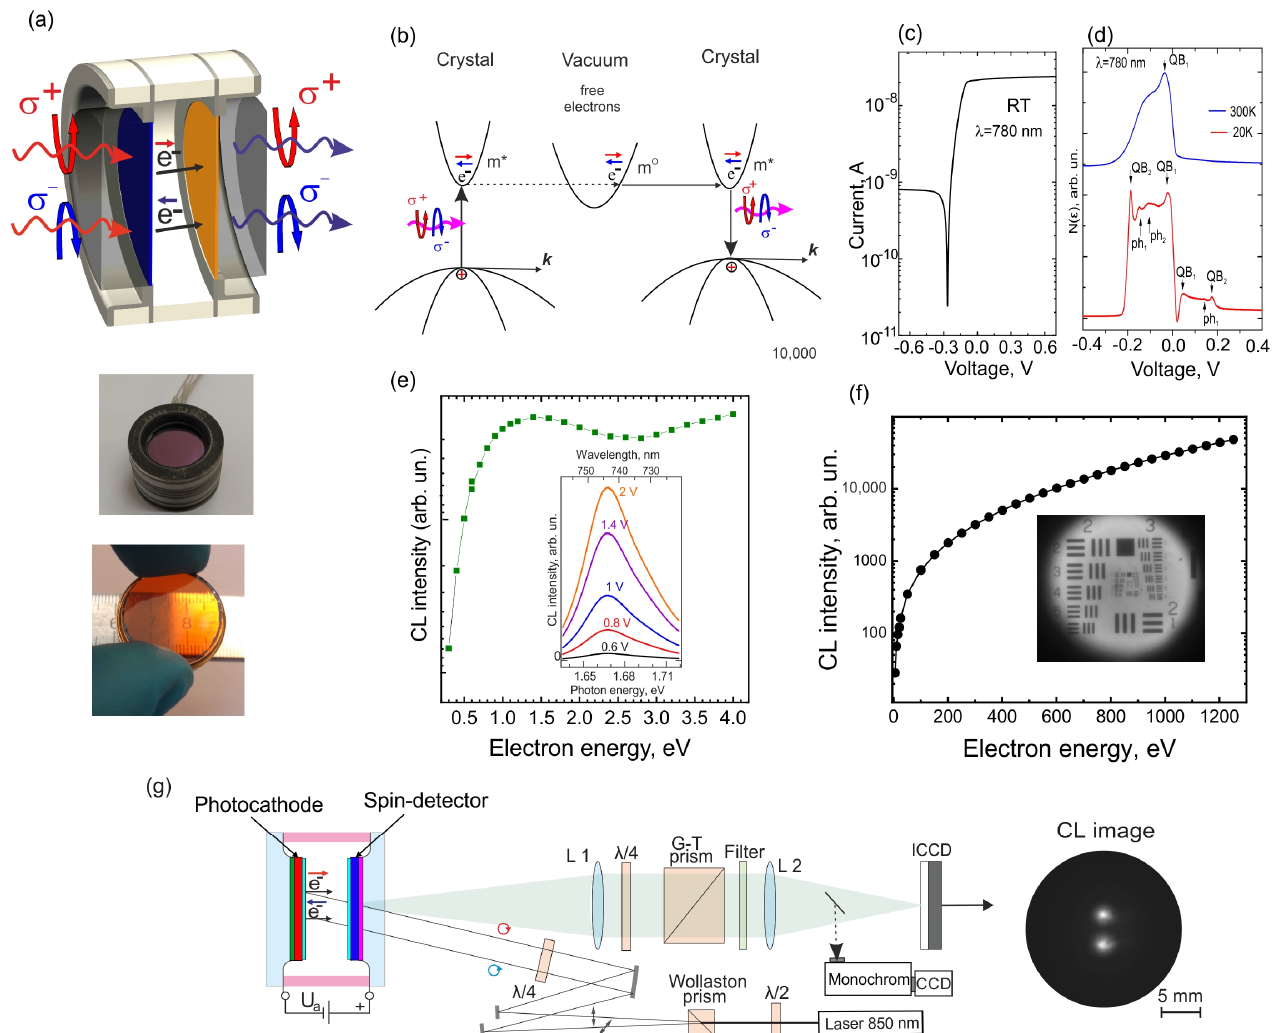
Figure 2. ( a ) Scheme in cross-section of compact vacuum photodiode for studying the emission and injection physics of spin-polarized electrons. Photographs below show the assembled photodiode from the photocathode side and the anode QW structure. The electrons photoemitted from the GaAs (Na 2 KSb) source are injected into the SC heterostructure with QW. ( b ) Schematic band structure of GaAs (Na 2 KSb) cathode and semiconductor anode near the Γ -point illustrating the photoemission process in vacuum and injection in semiconductor structure. m 0 - is the rest mass of an electron and m*- is the effective mass. ( c ) I-V curve illustrating the photodiode characteristic under the illumina- tion with the 780 nm wavelength. ( d ) Normalized energy distribution curves (EDC) at 300 and 20 K. ( e ) Dependence of CL intensity (logarithmic scale) on the electron energy injected into the Al x Ga 1- x As/GaAs/Al x Ga 1-x As heterostructure. The insert shows CL spectra measured at various accelerating biases. ( f ) Similar to ( e ), but measured at higher electron energy. Insert shows the CL image of the test chart detected at 1 keV electron energy by a standard CCD camera. ( g ) Schematic drawing of optical setup for spatial CL polarization detection. Electrons emitted by ℏ ν -photon excitation from the photocathode (GaAs or Na 2 KSb) source are injected into the spin-detector (QWs or Al 0.11 Ga 0.89 As) target.